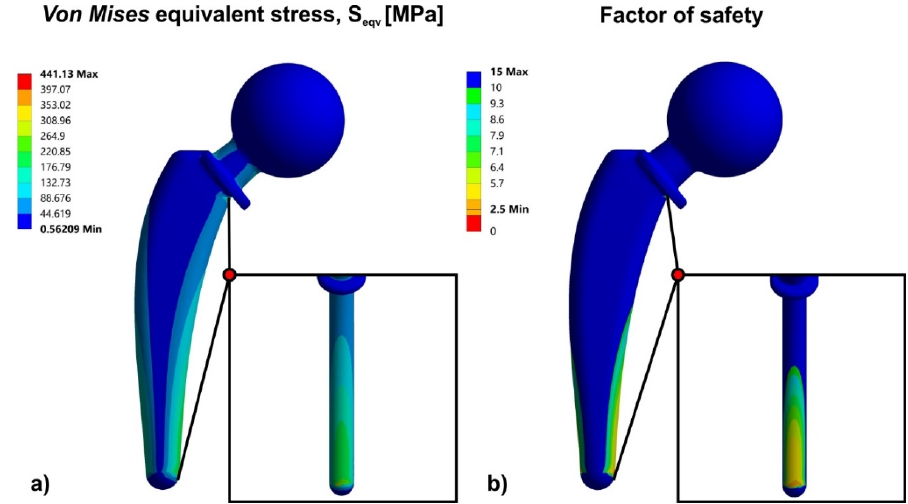
Figure 5. ( a ) Von Mises stress contour; ( b ) factor of safety (FOS) contour.